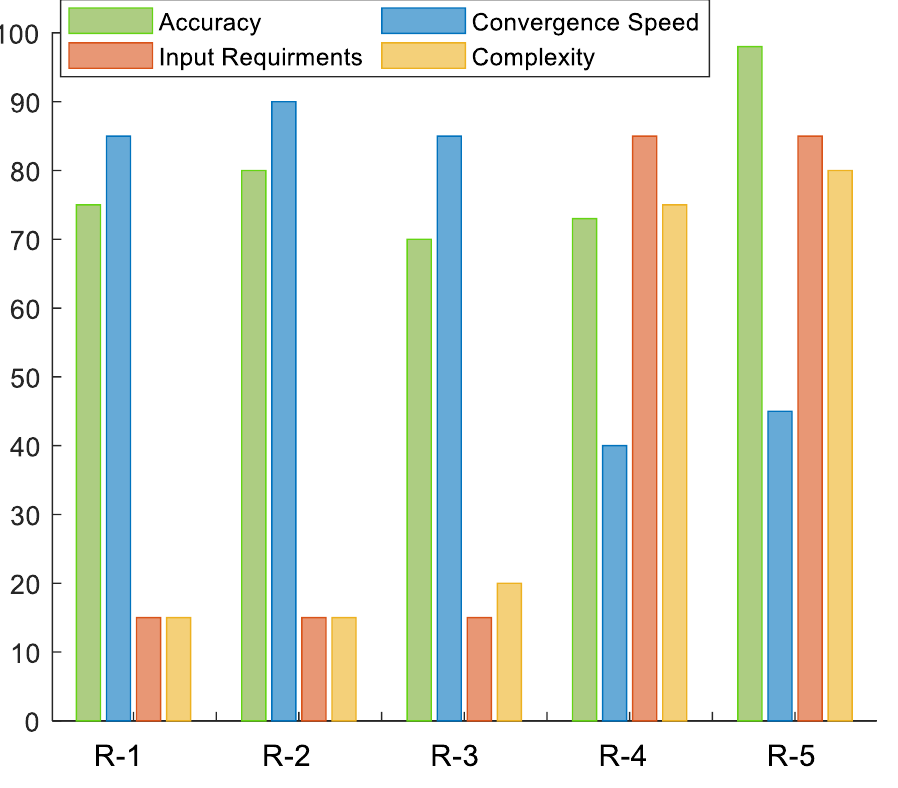
Figure 10. Bar chart of the trade-offs for each reward configuration .